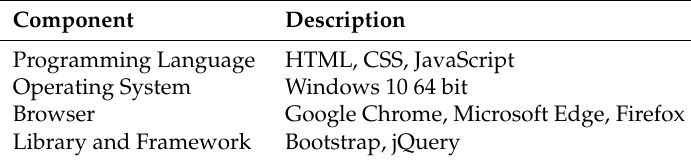
Table 2. Front-end development environment for the proposed drug supply chain